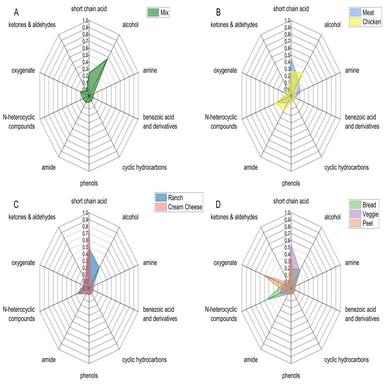
Radar charts presenting the GC–MS compound classifications for the hydrothermal liquefaction aqueous phase (HTL-AP) of the optimized HTL reaction conditions for each of the different food waste feedstocks (A: Mix; B: Protein Group; C: Lipid Group; D: Carbohydrate Group).